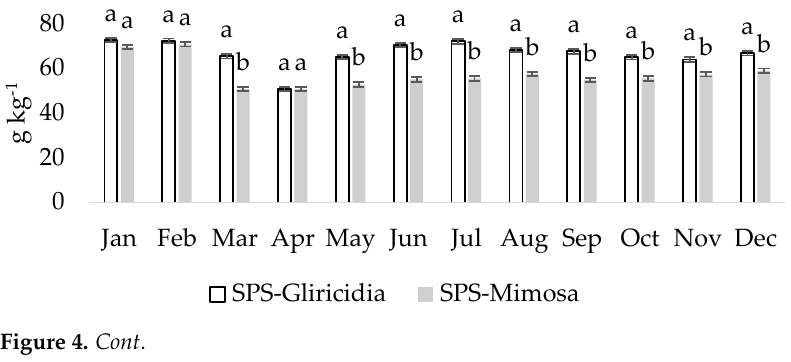
Figure 4. Crude protein of green leaf blade ( A ) and crude protein of green stem ( B ) (g kg −1 ) in signalgrass growing under Gliricidia and Mimosa during the experimental period. Data were averaged across replications and years. Small case letters are comparing treatments within each month in Figure 3A, and capital letters are comparing evaluations in Figure 3B. In both cases, equal letters are not different by the PDIFF adjusted by Tukey ( p > 0.05). SPS = silvopasture system. 3.4. Herbage Accumulation Rate There was a treatment × evaluation interaction for herbage accumulation rate (HAR) (Figure 5). Herbage accumulation rate was always greater for signalgrass growing in the Gliricidia compared with Mimosa. The HAR peaked in July (71 kg DM ha −1 d −1 for Gliricidia and 48 kg DM ha −1 d −1 for Mimosa) and had its least growth rate in December (22 kg DM ha −1 d −1 ), coinciding with greater and lower rainfall, respectively; however, Gliricidia did not follow the rainfall pattern as Mimosa has a lower HAR occurring in May (41 kg DM ha −1 d −1